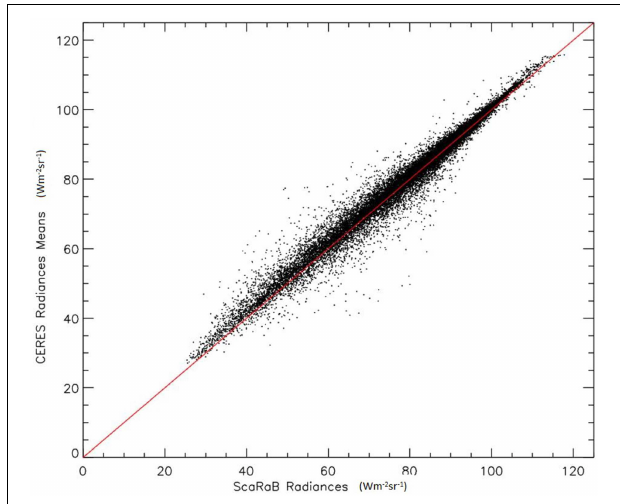
FIGURE 5 | Scatterdiagram of LW radiances in Wm − 2 sr − 1 from ScaRaB vs. CERES FM1 data during the coincidence campaign in 2012. From Chomette et al. (2015).